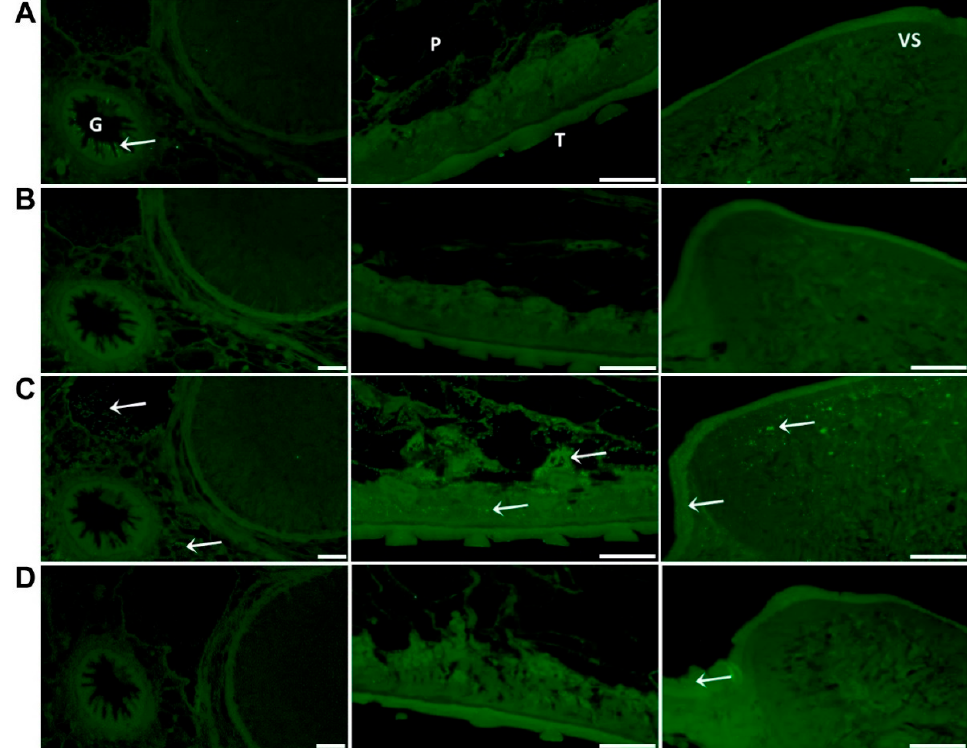
Figure 5. Immuno-localisation of native FhSOD1 and FhSOD3 in F. hepatica adult sections. Sections were probed with ( A ) anti-rFhCL1 polyclonal antibodies (non-related positive control), ( B ) rabbit pre-immune sera (negative control), ( C ) anti-rFhSOD1 polyclonal antibodies, and ( D ) anti-rFhSOD3 polyclonal antibodies raised in rabbit. Immuno-localisation of native F. hepatica proteins is represented by green fluorescence (FITC staining) and indicated with white arrows. G; gut, P; parenchyma, T; tegument, VS; ventral sucker, scale bars 50 µM. Whole mount immuno-localisation of NEJ 3 h post-excystment using anti-rFhSOD1